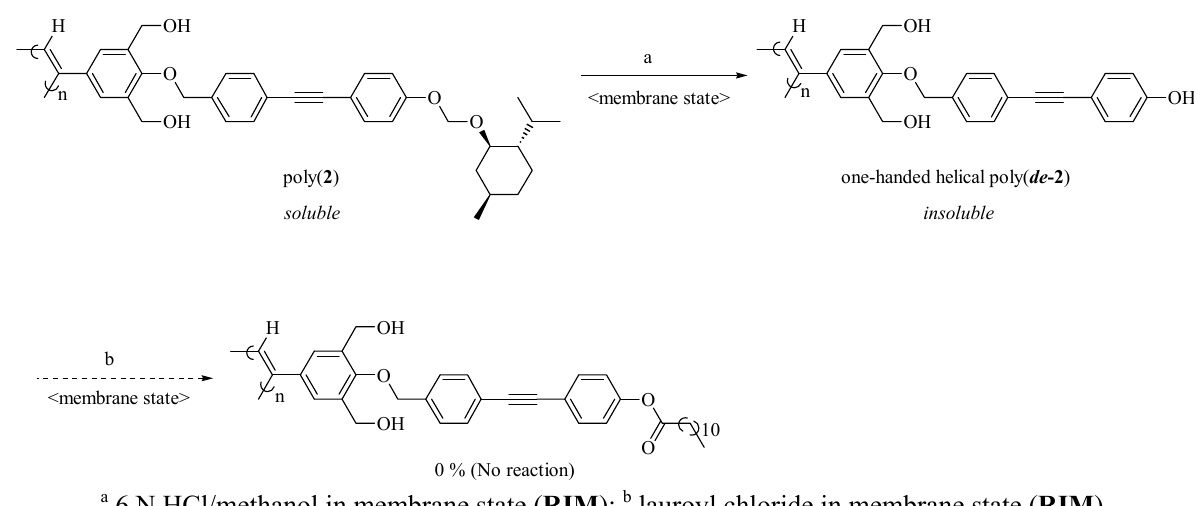
Scheme 3. Synthesis of insoluble one-handed helical poly( de -2 ) by polymer reaction in membrane state( AIP-RIM